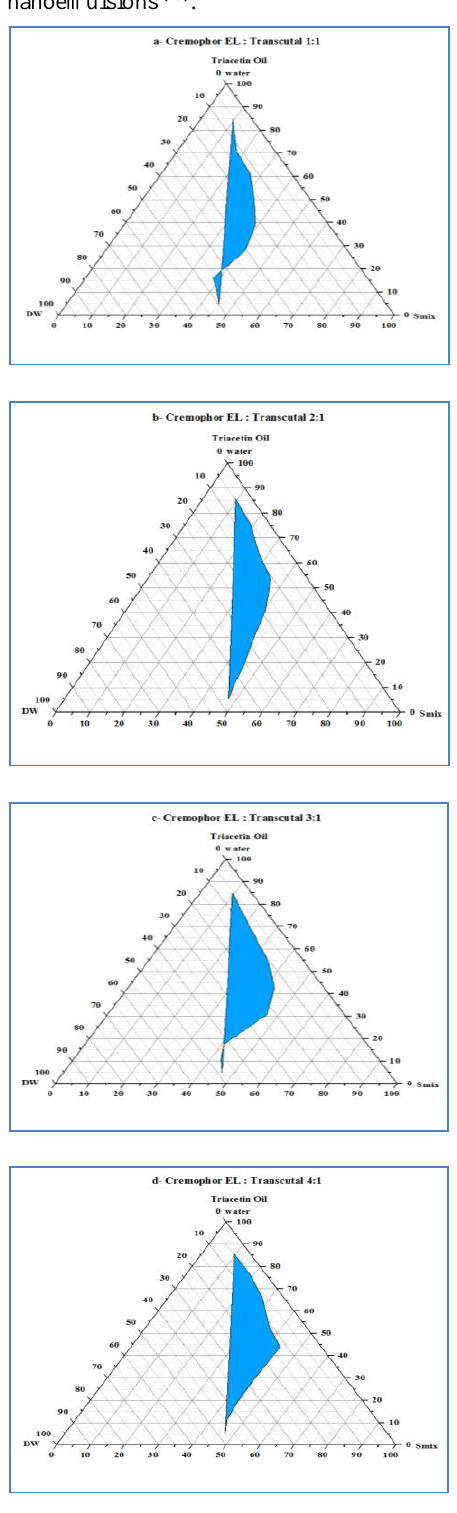
Figure 1. The diagram plot for pseudo ternary phase for different S mix ratio (cremophore EL: transcutol HP 1:1, 2:1, 3:1 and